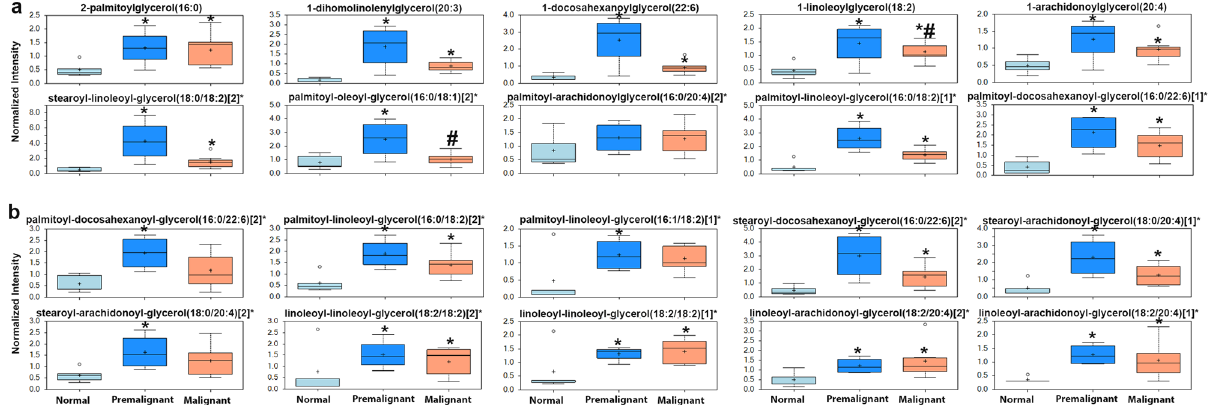
Figure 4. Expression of ( a ) mono-acyl glycerols, and ( b ) di-acylglycerols in premalignant and early malignant lesions. * p < 0.05 compared to normal, and # p < 0.05 comparing premalignant and early malignant lesions, one- way ANOVA with multiple comparisons.